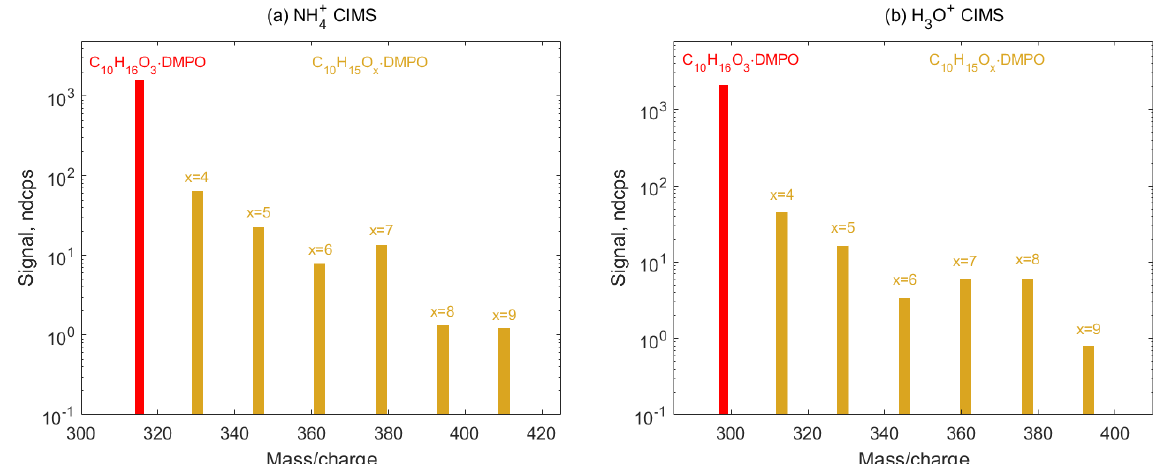
(cid:113) (cid:113) Figure 8. Mass spectra of SCI DMPO (yellow) adducts in α -pinene ozonolysis experiments observed using (a) NH + DMPO (red) and RO 2 CIMS and (b) H 3 O + CIMS. Primary RO 2 species (C 10 H 15 O 4 ) are formed via CI isomerization and can in turn undergo various autoxidation reactions resulting in the formation of several organic peroxy radicals (C 10 H 15 O x , x = 5–9), which were detected as adducts with the spin trap DMPO via NH + and H 3 O + 4